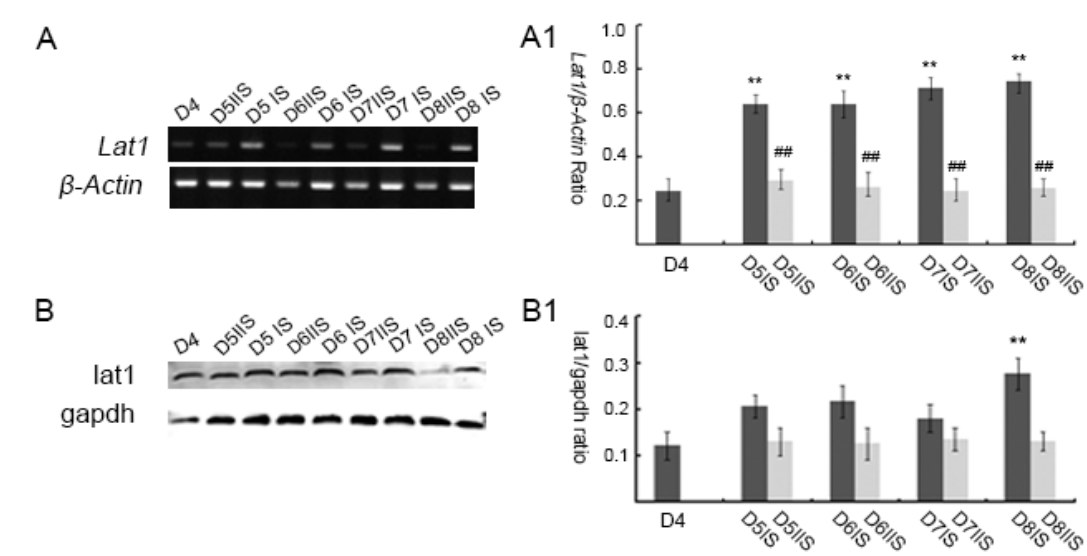
Figure 2. Expression of lat1 in mouse uterus from D4 to D8 of pregnancy. To distinguish implantation and inter-implantation sites, trypan blue was injected by caudal vein on D5 and D6: ( A , A1 ) semi-quantitative RT-PCR analysis of the Lat1 mRNA in mouse uterus from D4 to D8 of pregnancy; and ( B , B1 ) Western blot analysis of the lat1 protein in mouse uterus from D4 to D8 of pregnancy (IS: implantation sites, IIS: inter-implantation sites). ** p < 0.01, as compared with D4; ## p < 0.01, the expression of lat1 in inter-implantation sites compared with corresponding implantation sites. There were 15 mice sacrificed on every day of pregnancy.